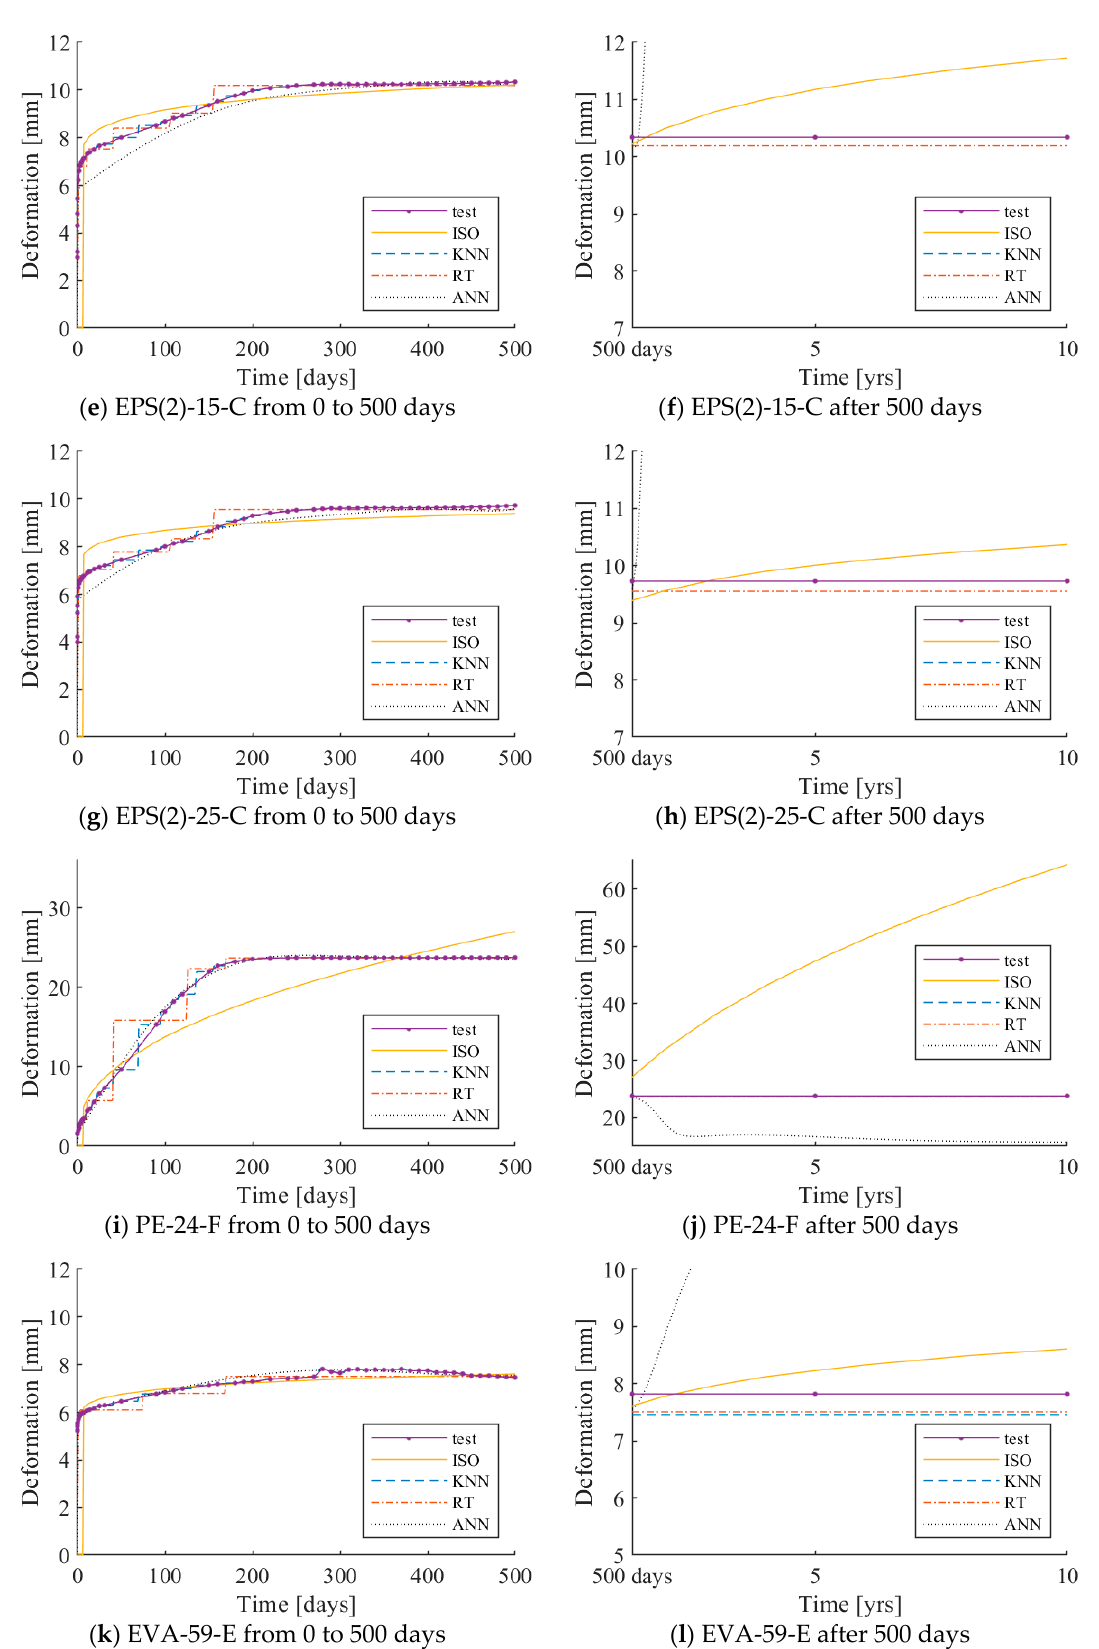
Figure 6. Long-term deformations as predicted by ISO 20392 (solid), k-nearest neighbor (KNN, dashed), regression tree (RT, dash-dot), and artificial neural networks (ANN, dotted) compared to the experimental data under 250 N loading.